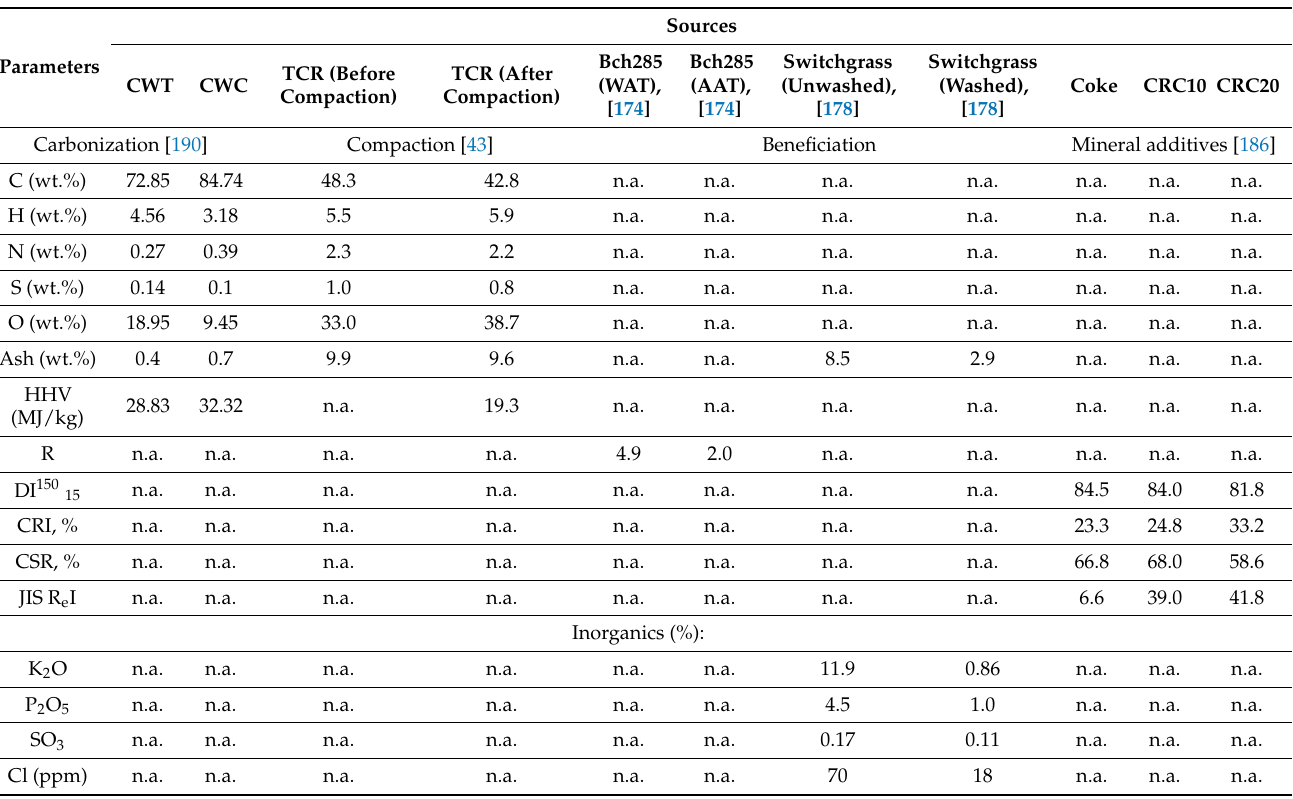
Table 10. Effect of different modification techniques on the example of different types of carbon